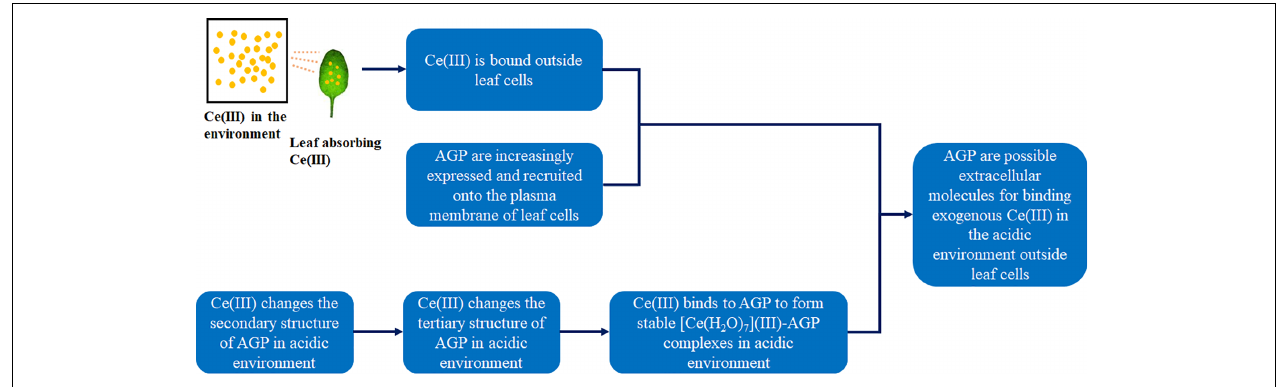
FIGURE 10 | The confirmation of AGP being the possible extracellular molecules for binding to exogenous Ce(III) outside leaf cells.